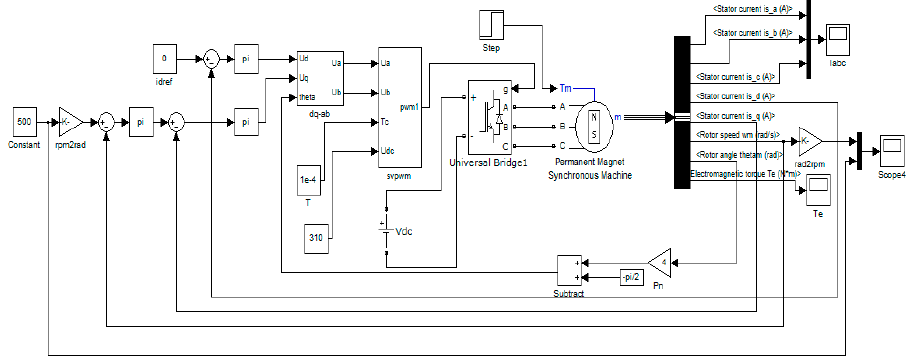
Figure 3. Open-loop model of PMSM.